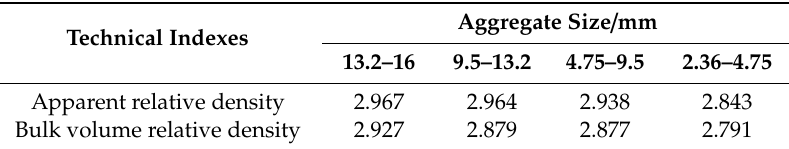
Table 1. Main technical indexes of coarse aggregate.